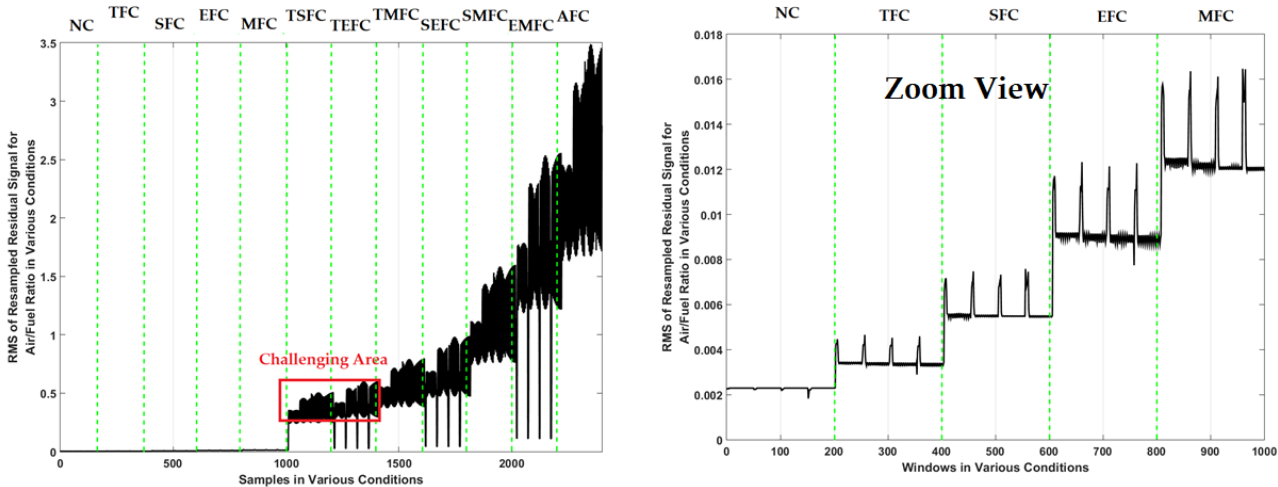
Figure 8. Resampled RMS residual signals for air-to-fuel ratio using the FGAL-LCR technique.